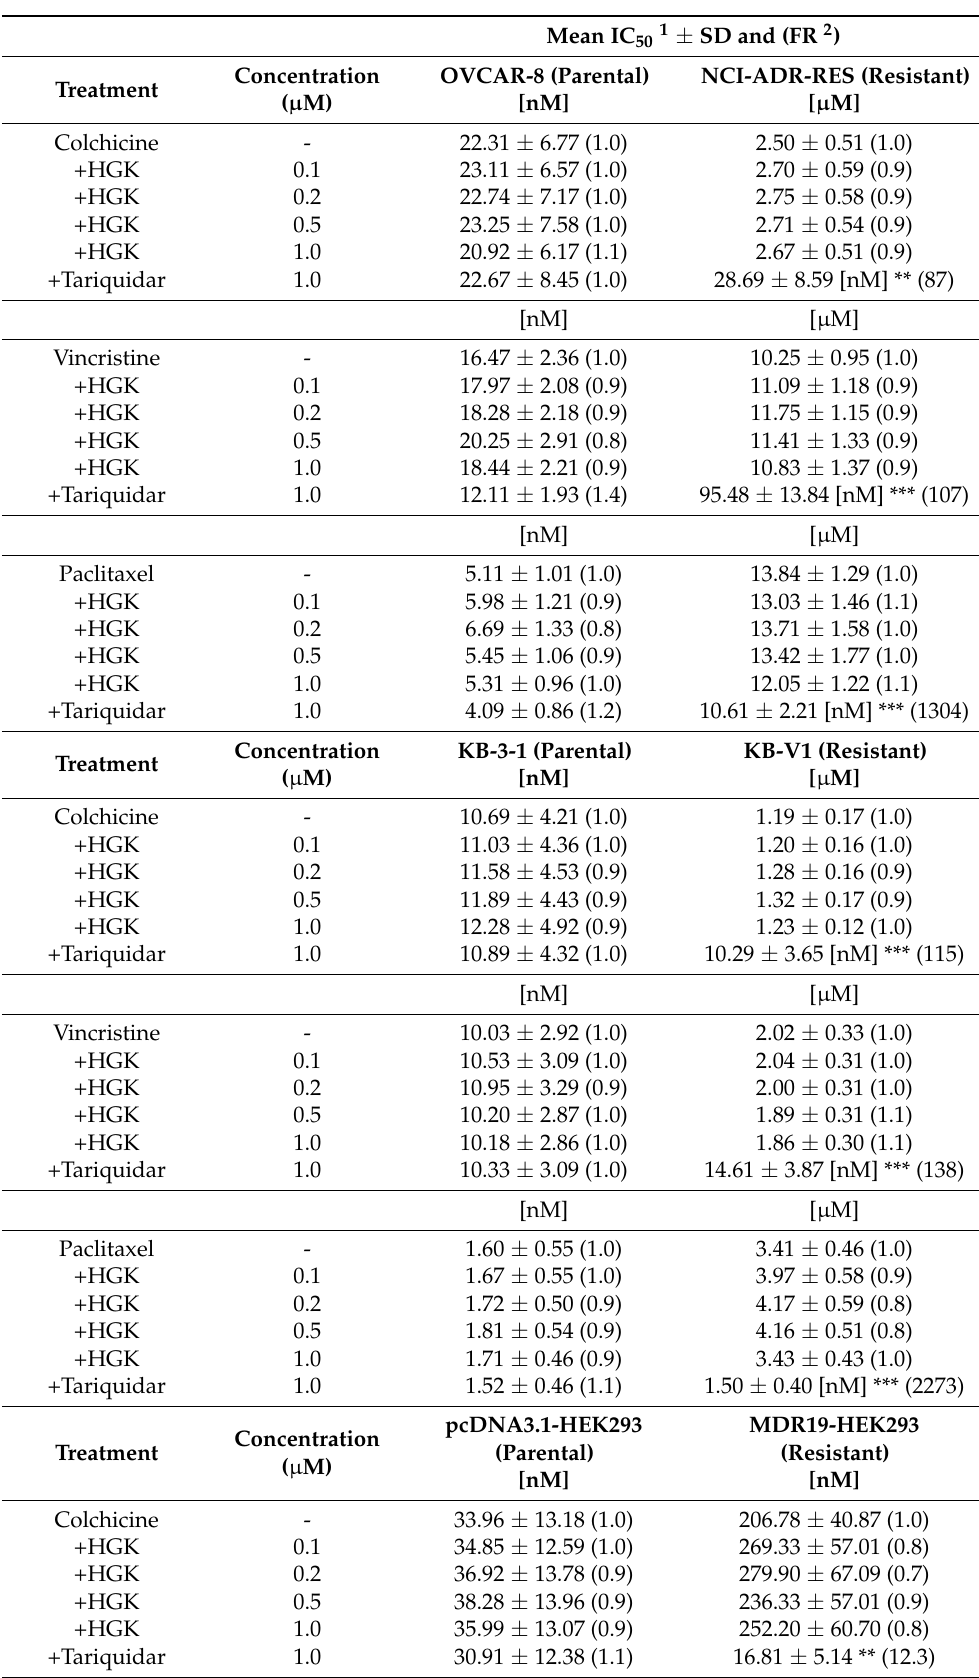
Table 2. The effect of hydroxygenkwanin on reversing ABCB1-mediated multidrug resistance in drug-resistant human cell